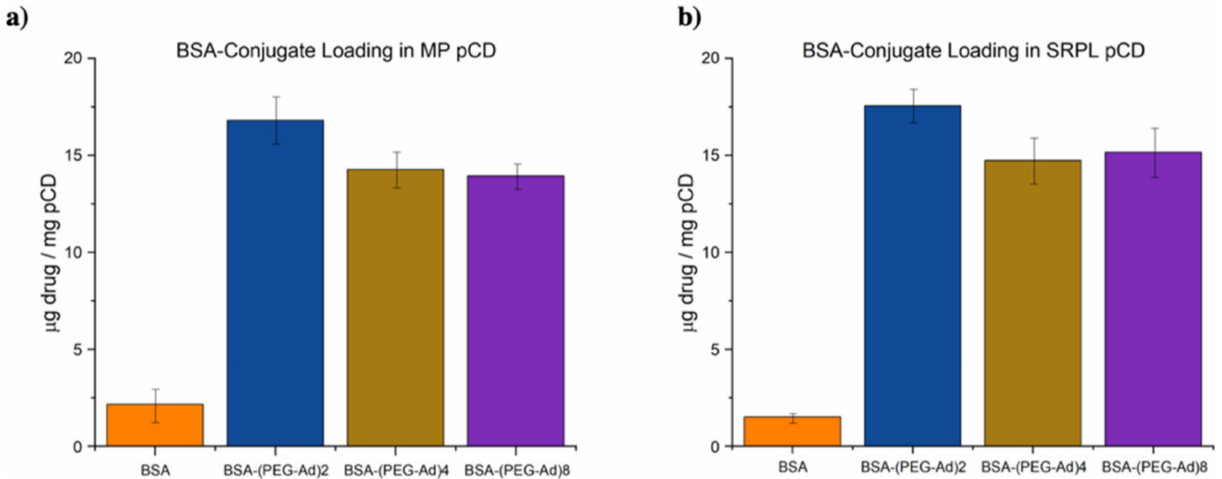
Figure 6. Total loaded drug normalized to pCD weight (10 mg) for BSA–polymer conjugates for ( a ) pCD MPs and ( b ) pCD